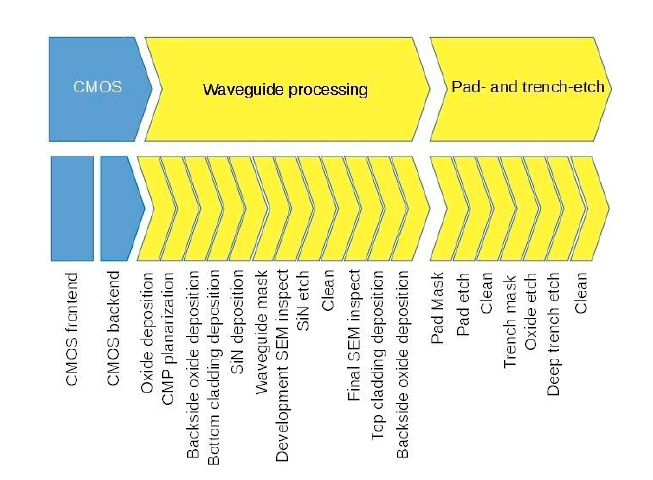
Figure 1. Schematic of the post-processing flow for waveguide integration on CMOS wafers. Waveguides and photonic components are processed after CMOS front- and back-end and are finished with optional etching the pads and a deep trench on the edges of the PIC to facilitate butt- coupling with optical